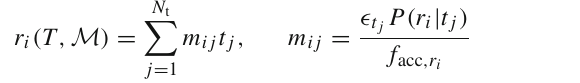
Fig. 2 Comparison of observed data with the predicted distribution of a the top-quark energy, b the antitop-quark energy, and c the angle θ j before unfolding (pre-marginalisation). The expectations for the t fiducial and non-fiducial signal are represented by the white and grey areas, respectively, while all non- t ¯ t backgrounds are added up in the as